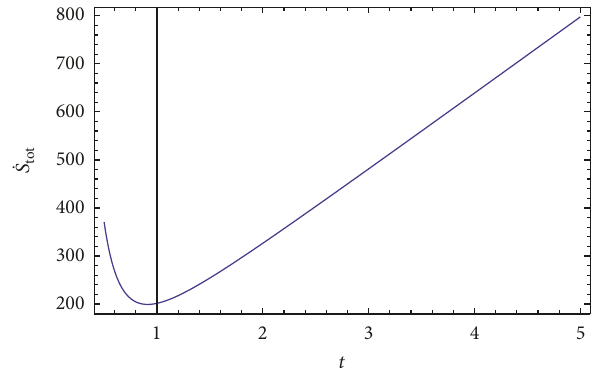
̇𝑆 Figure 11: Plot of tot by taking logarithmic entropy as entropy at event horizon, where time is measured in seconds.